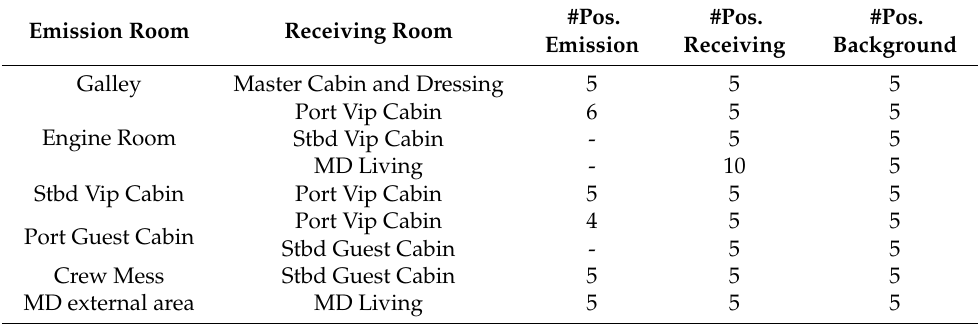
Table 3. Number of SPL measurements for D nT